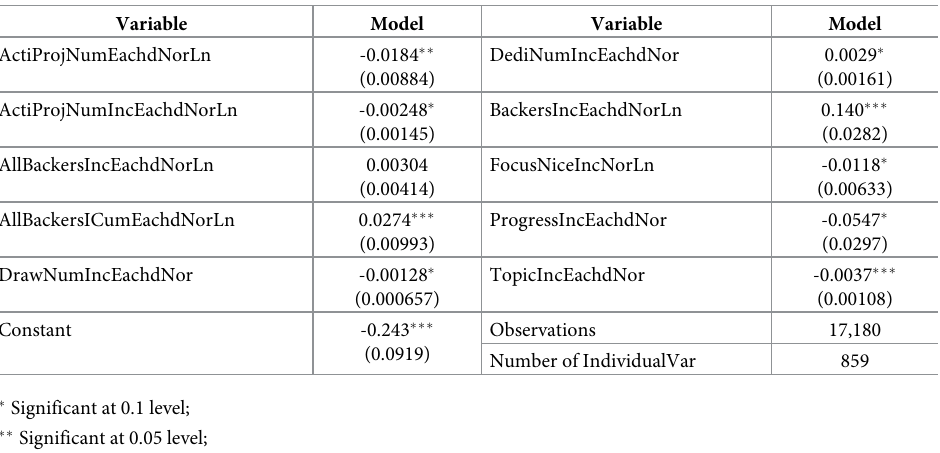
Table 8. Fixed effect on the implicit signals of projects.